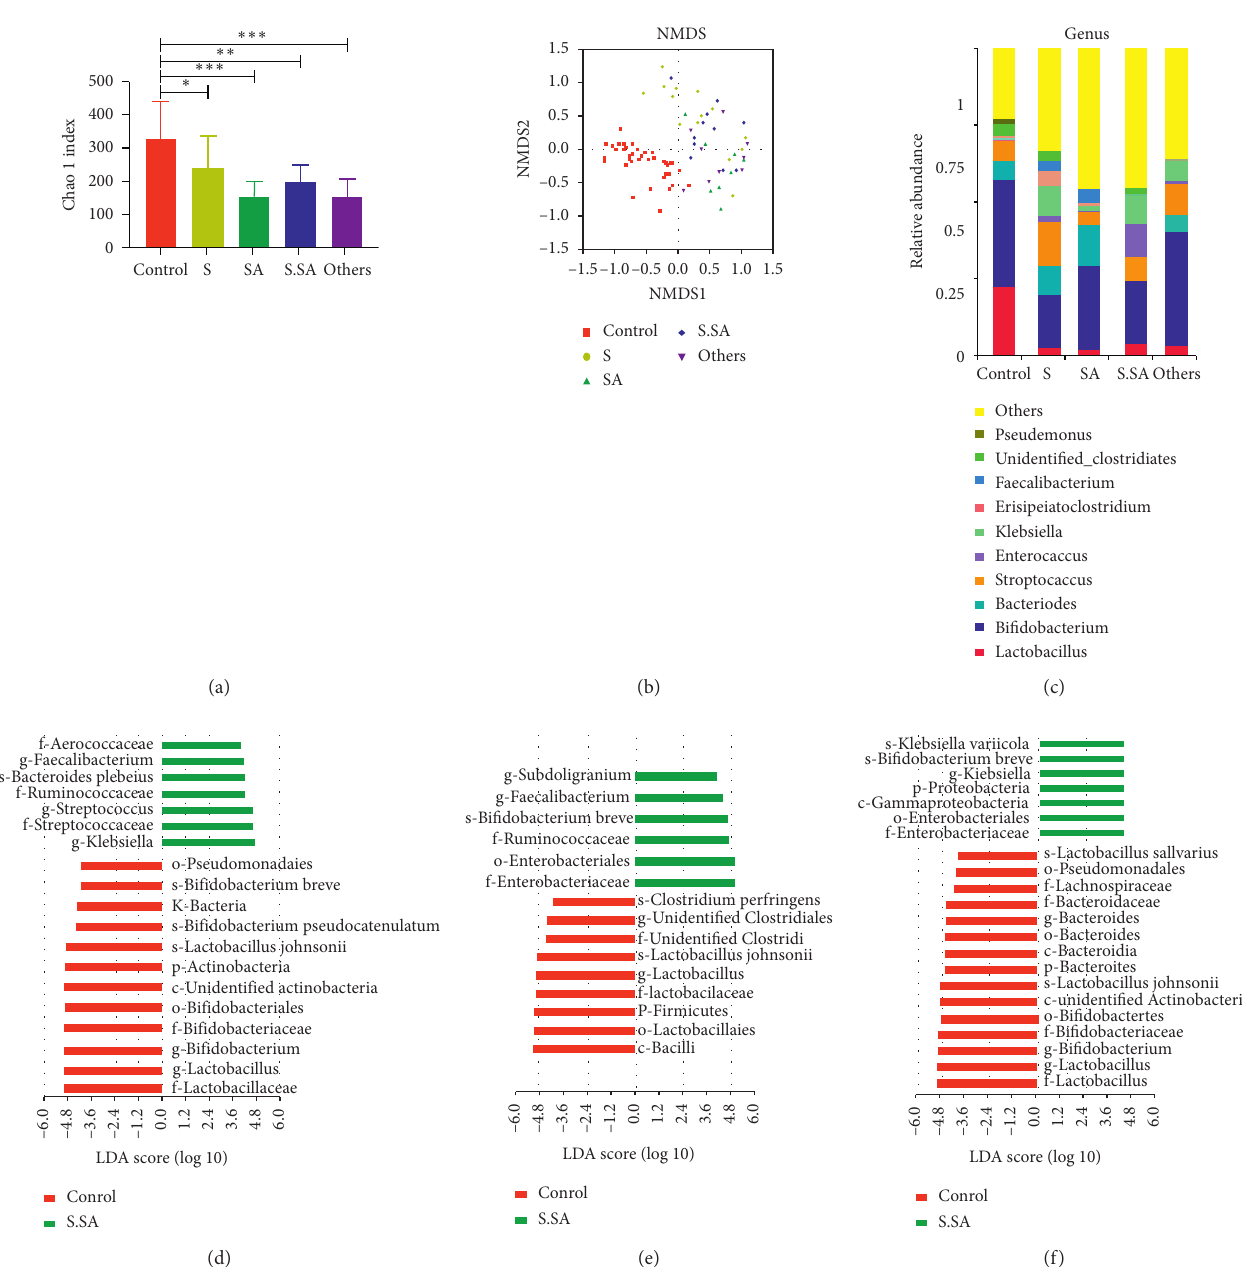
Figure 6: The gut microbiota of diarrheic infants infected by different pathogens. (a). The comparison of the alpha diversity (Chao 1 index) of different groups (control, Salmonella (S), Staphylococcus aureus (SA), combined Salmonella and Staphylococcus aureus (S.SA), and others) based on the OTU profiles. (b). The NMDS of beta diversity was calculated on ranking order. (c). The relative abundance of the top 10 microbiota at the genus level of different groups. (d–f). The LEFSe method analysis of the predominant bacteria between different